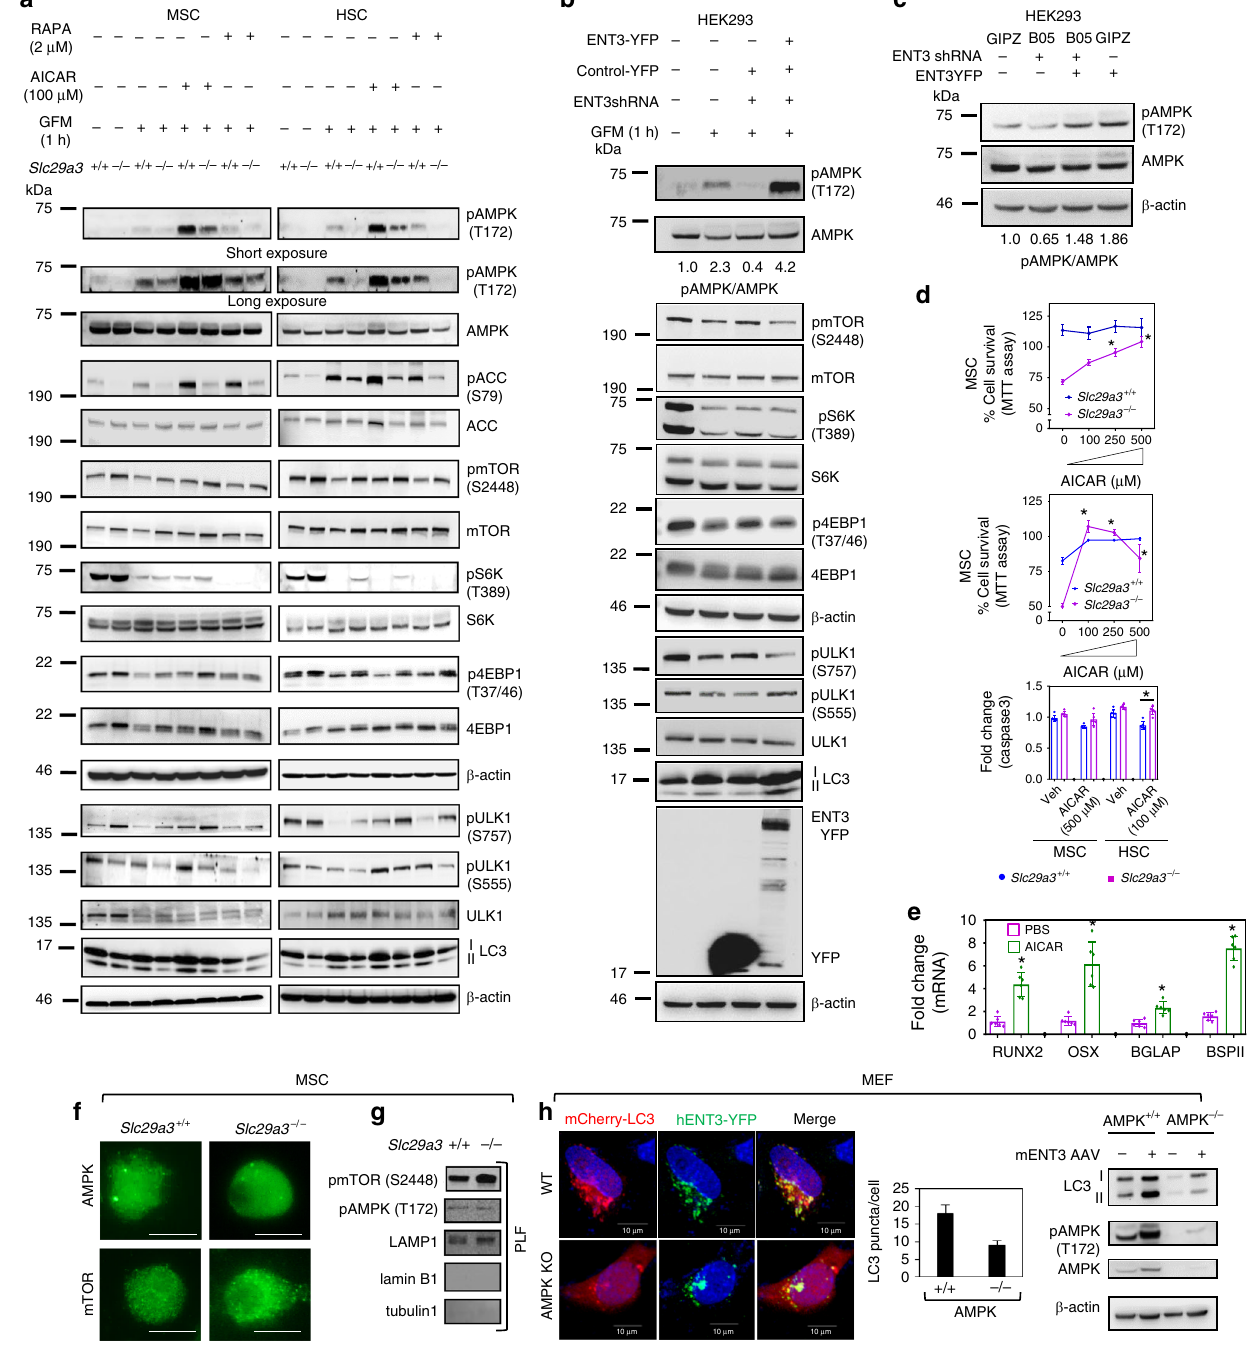
(Fig. 9k). When bone marrow erythroid subpopulations were further characterized, we observed a reversal of the changes in the proportion of cells at various erythroblast maturation stages in the SCT group compared with that in Slc29a3 − / − mice at 12 weeks of age (Fig. 9l and Supplementary Fig. 11b). The reduced proportion of immature stages (proerythroblasts (ProE), basophilic erythroblasts (EryA), late basophilic erythroblasts (EryB)) observed in Slc29a3 − / − mice at 12 weeks of age was increased in the SCT group to levels beyond that seen in the WT group, suggesting the expansion of erythroid precursors in the SCT group (Fig. 9l). This shift towards an immature population resulted in a percent decrease in the